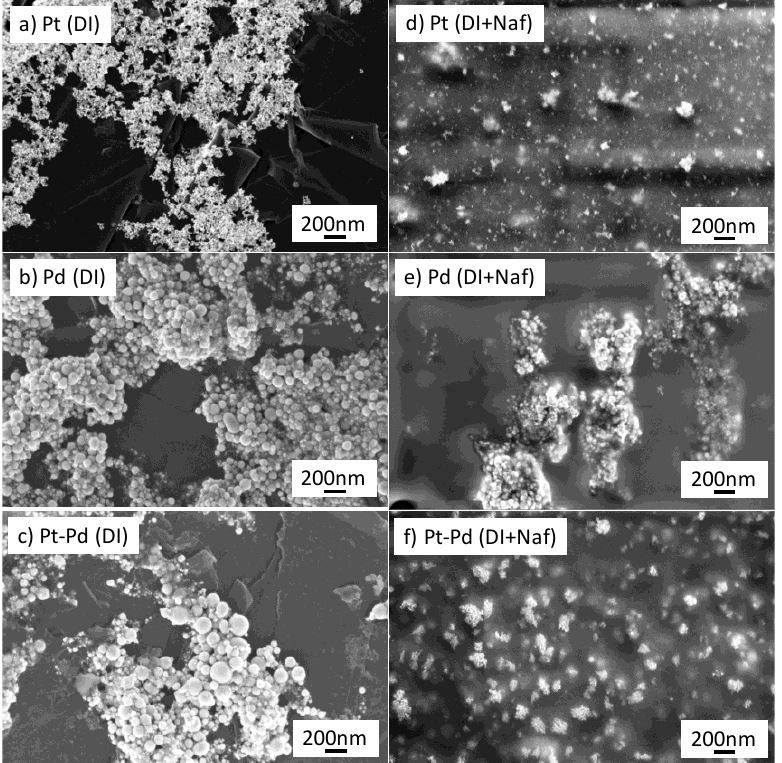
Figure 2. Field emission scanning electron microscopy pictures of NPs-GP nanocomposites: ( a – d ) Pt in deionized water and in Nafion solution; ( b – e ) Pd in deionized water and in Nafion solution; ( c – f ) Pt 80 Pd 20 in deionized water and in Nafion